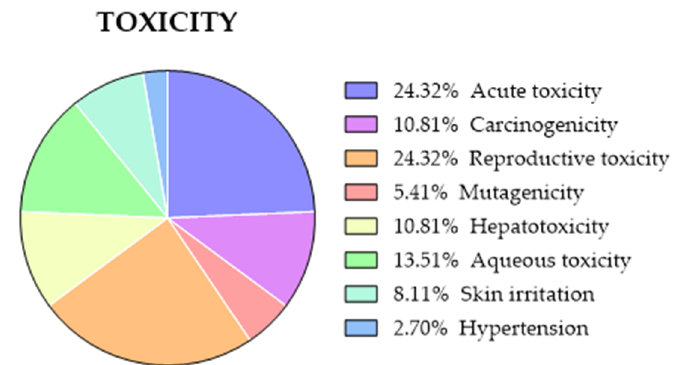
Figure 10. Types of toxicity described for the 24 TKIs under study: acute toxicity ( n = 9), carcinogenicity ( n = 4), reproductive toxicity ( n = 9), mutagenicity ( n = 2), hepatotoxicity ( n = 4), aqueous toxicity ( n = 5), skin irritation ( n = 3) and hypertension ( n = 1).